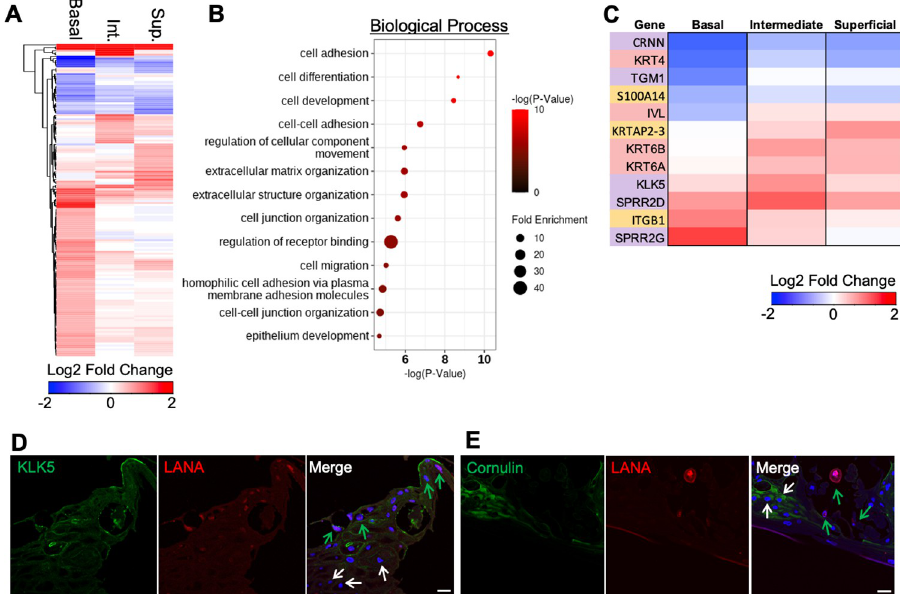
Fig 4. KSHV predominantly affects basal epithelial cells in KSHV-infected tissues. (A) Heatmap of significantly upregulated and downregulated genes in all KSHV-infected cells compared to bystander cells within each epithelial layer (3 and 6 dpi combined). Significant genes have a |fold change| > 1.5 and p-value < 0.05. (B) Gene ontology analysis of the top pathways affected by KSHV infection within basal epithelial cells. This analysis compares basal KSHV-infected cells to bystander cells with the color of each dot representing the p-value and the fold enrichment (observed # of genes/expected # of genes). (C) Heatmap of keratinocyte differentiation related genes. Basal layer genes are highlighted in gold, intermediate layer genes are highlighted in red, and superficial layer genes are highlighted in purple. Log2 fold change represents the average fold change when comparing KSHV-infected cells and bystander cells within each epithelial layer. Co-staining of KLK5 and LANA or (D) cornulin and LANA (E) in 3D oral epithelial cultures at 6 dpi with overlay of Hoechst staining (blue). LANA+ KSHV infected cells are indicated by green arrow. LANA- bystander cells are indicated by white arrow. Scale bar = 25 μ